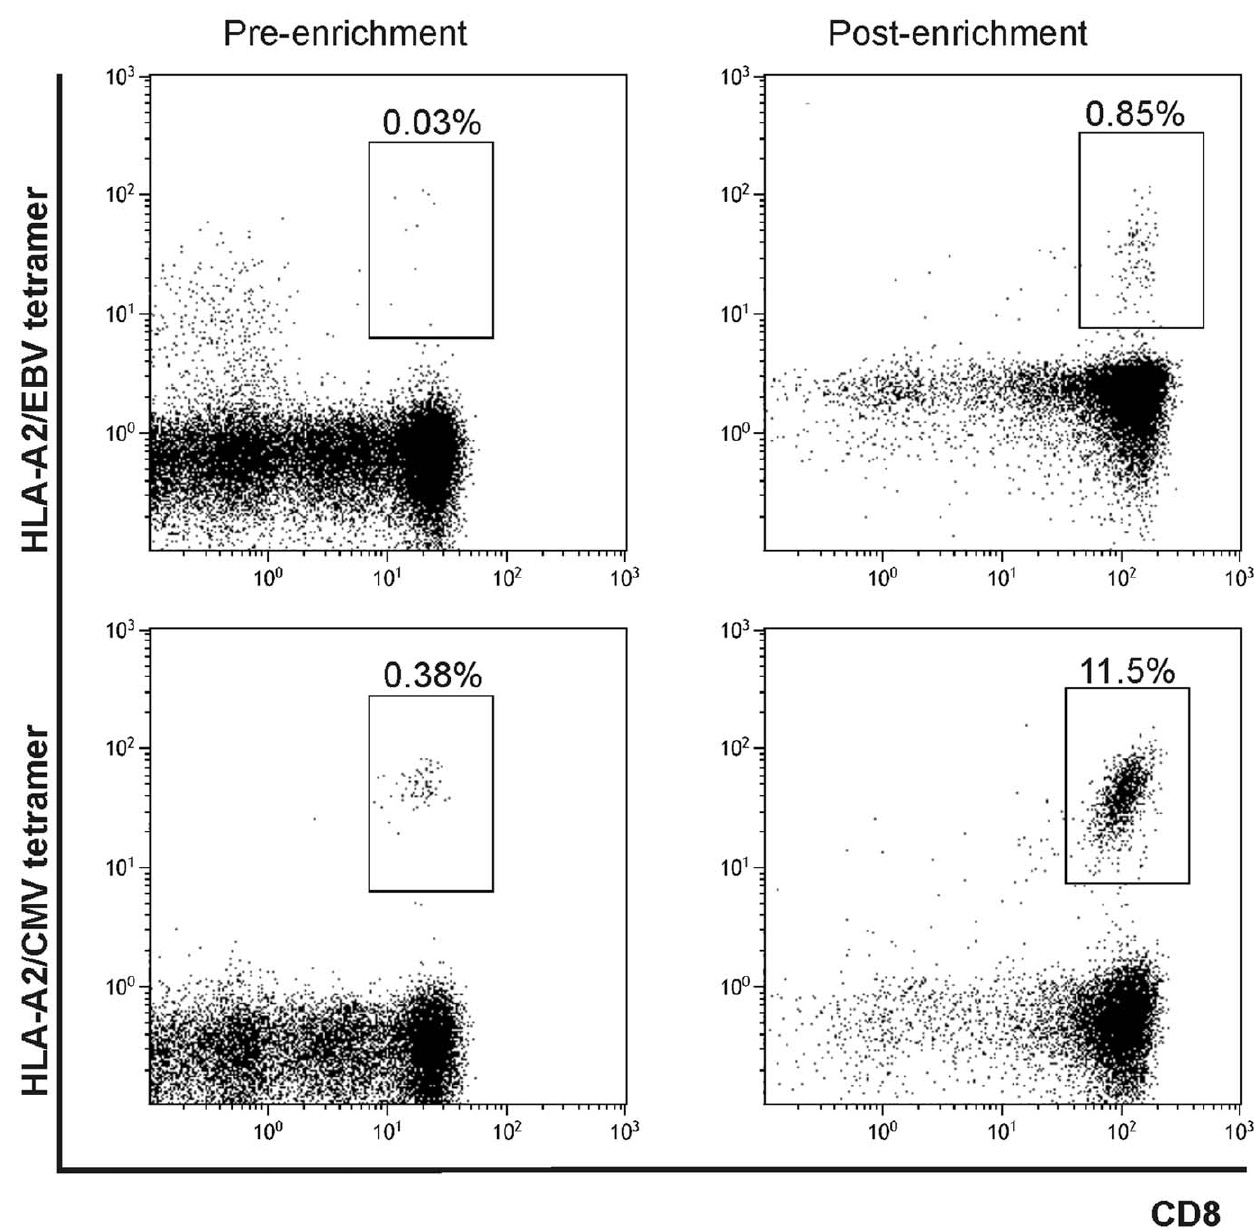
Figure 4. PBMC of a healthy donor enriched for virus-specific T cells. Peripheral blood of an HLA-A2 + healthy donor was enriched for EBV- and CMV-specific CD8 + T cells. Before culture there were low amounts of EBV- and CMV-specific CD8 + T cells present, which showed an increase after enrichment and 16 days of culture. Cells were stained with tetramers coupled to PE and gated on CD8 + tetramer + . Analysis was performed on the Cyan